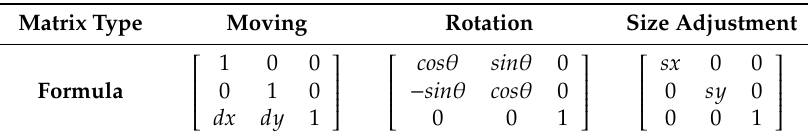
Figure 5. Collected WRM and image map: ( a ) before map correction and ( b ) after adopting map correction. Table 1. Transformation matrix for the map